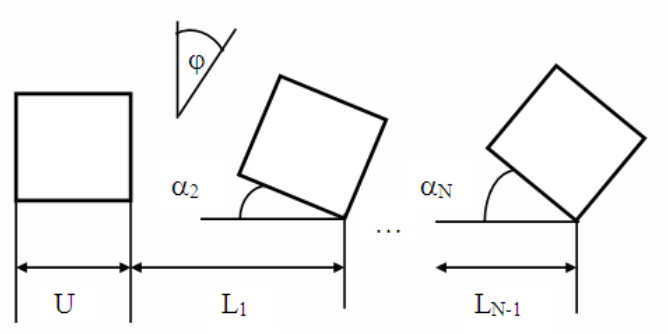
Fig. 1. The scheme of scattering of electromagnetic waves on an object consisting of many